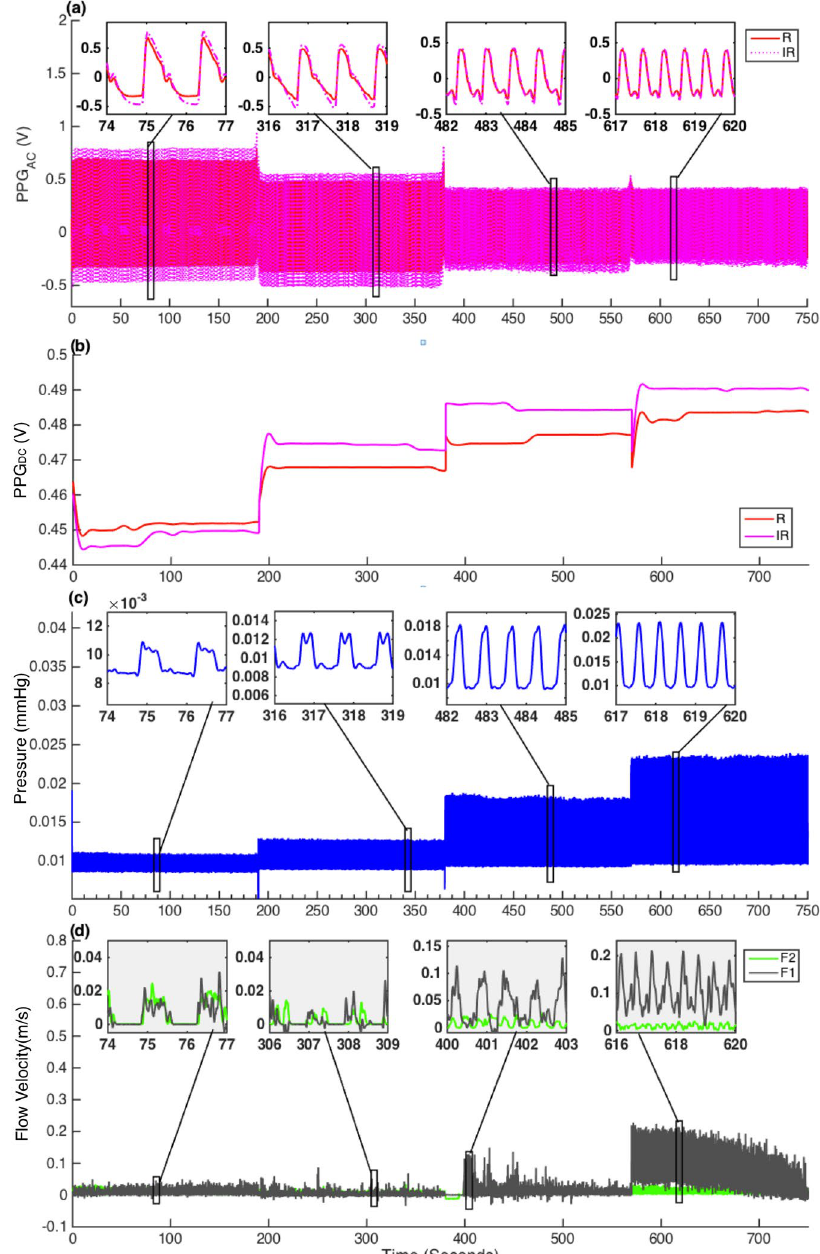
Figure 3. Signals collected during circulating whole equine blood. Data was obtained at 190 seconds for each pumping frequency (0.7, 1, 1.5 and 1.9 Hz). ( a ) Red (R) and Infrared (IR) PPGAC signals. ( b ) R and IR PPGDC levels. ( c ) Pressure (P) signals and ( d ) shows forward (F1) and backward (F2) flow